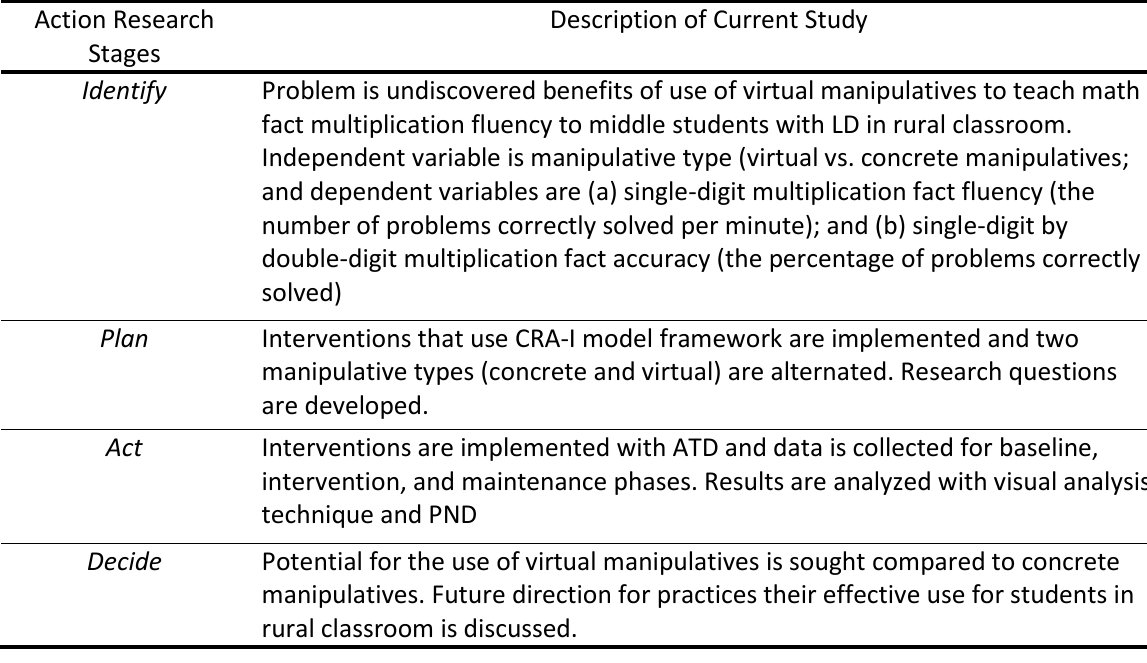
Table 2: Four Stages of Action Research Action